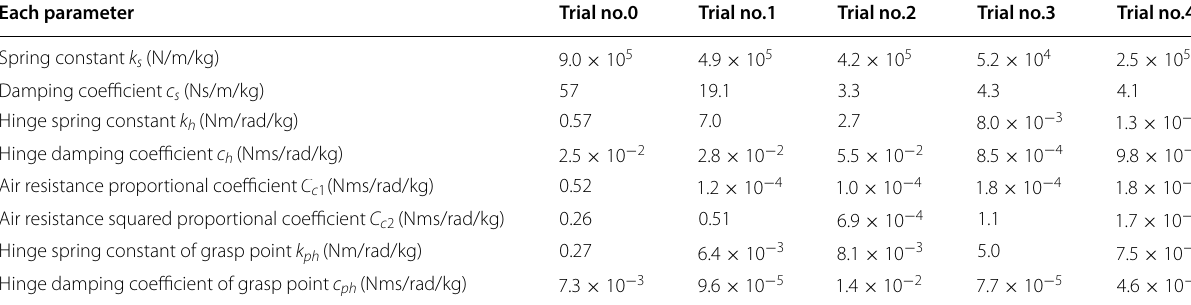
Table 4 Reproducibility of estimated parameters (desired image of string: J) Each parameter Trial